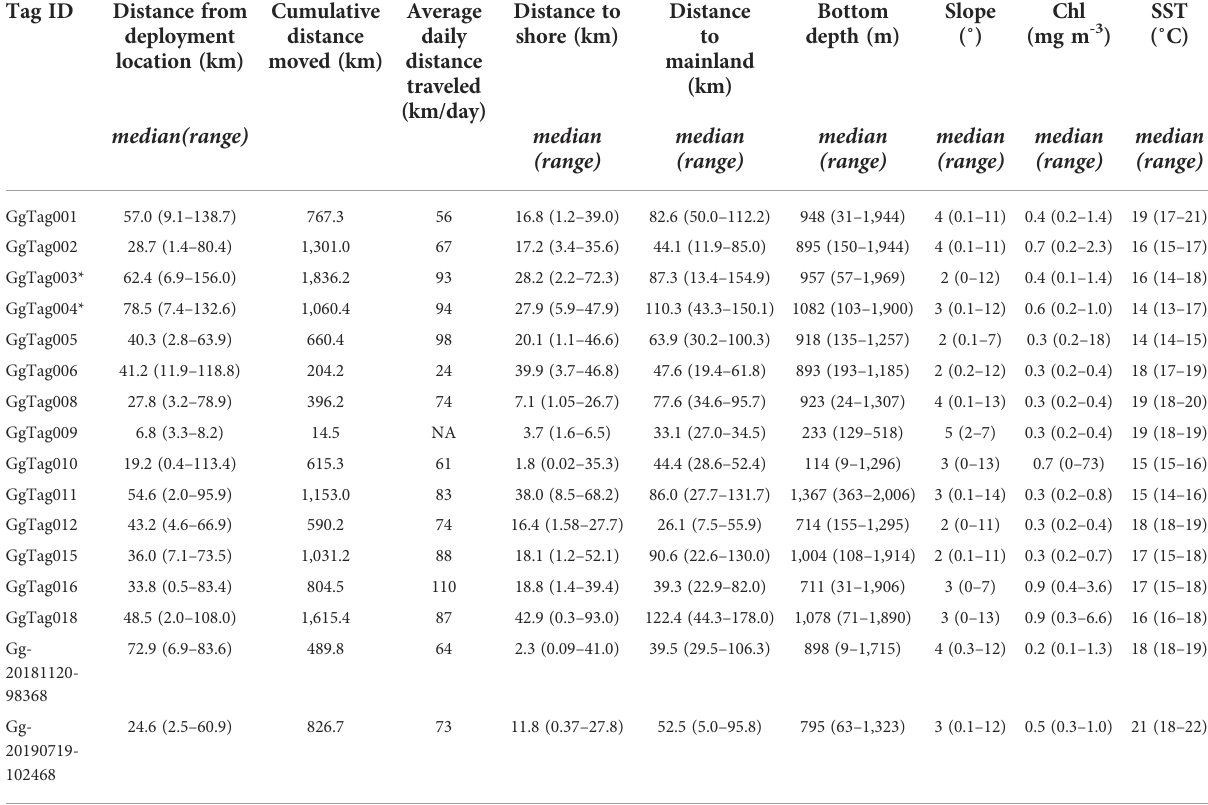
TABLE 2 Summary of habitat characteristics at fi ltered Argos locations for individual Risso ’ s